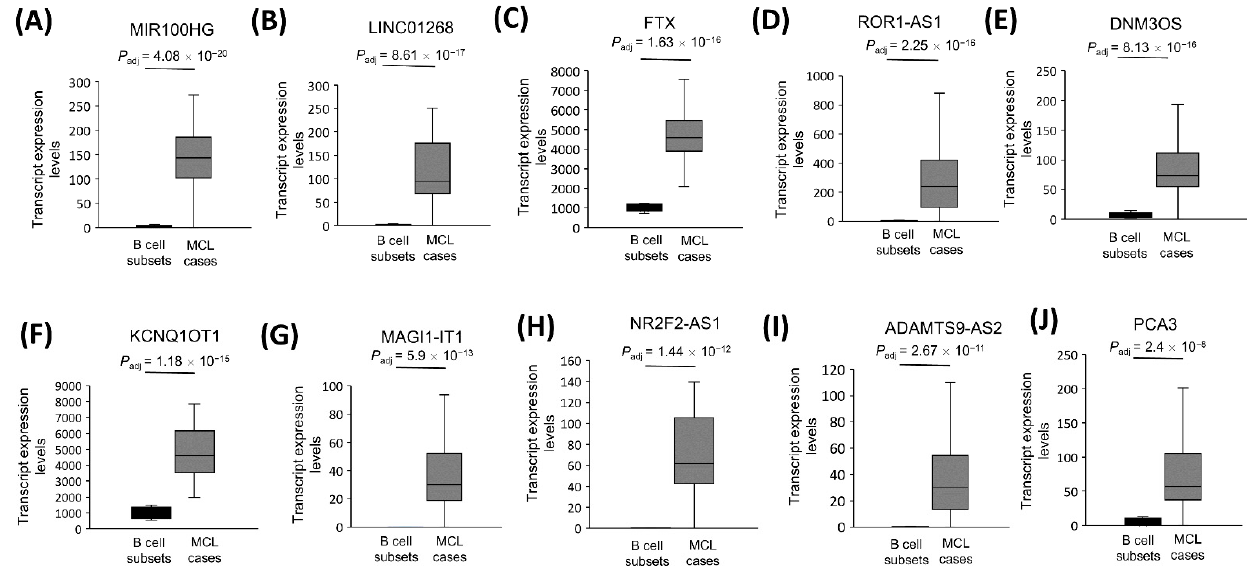
Figure 7. The transcript levels of top 10 cancerogenesis-associated lncRNA genes. Box-and-whisker plots of the 10 cancerogenesis-associated lncRNAs that are most significantly overexpressed in 32 MCL tumor samples compared with the 5 reactive tonsil B-cell subtype samples are shown in the order of decreasing statistical significance ( A–J ).